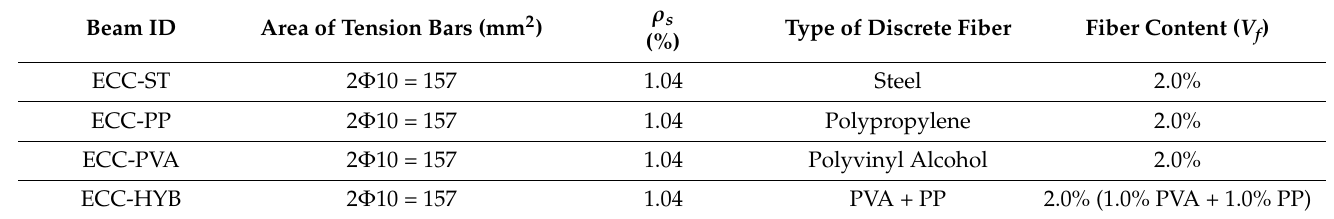
Table 2. ECC member details used.